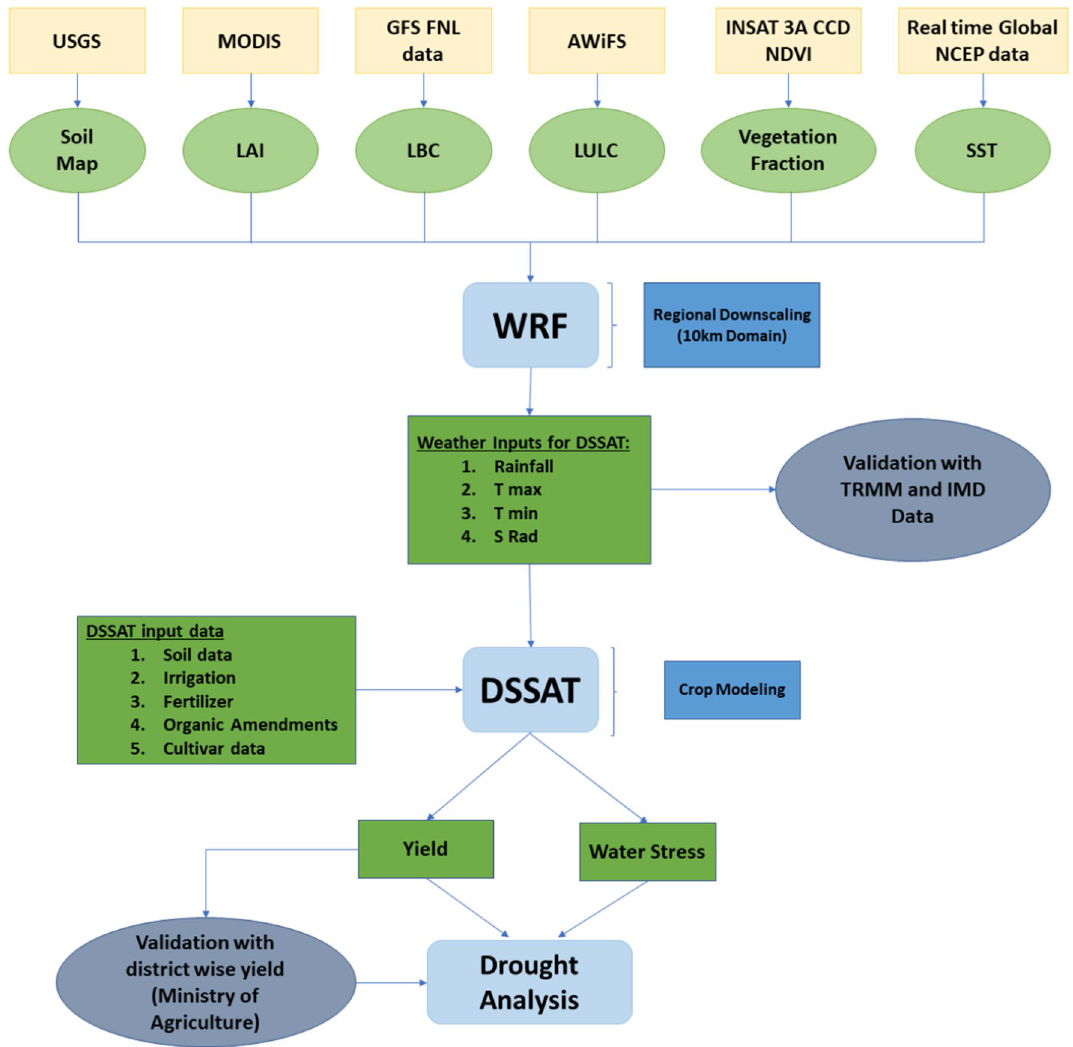
Figure 3. The overall methodology used in this